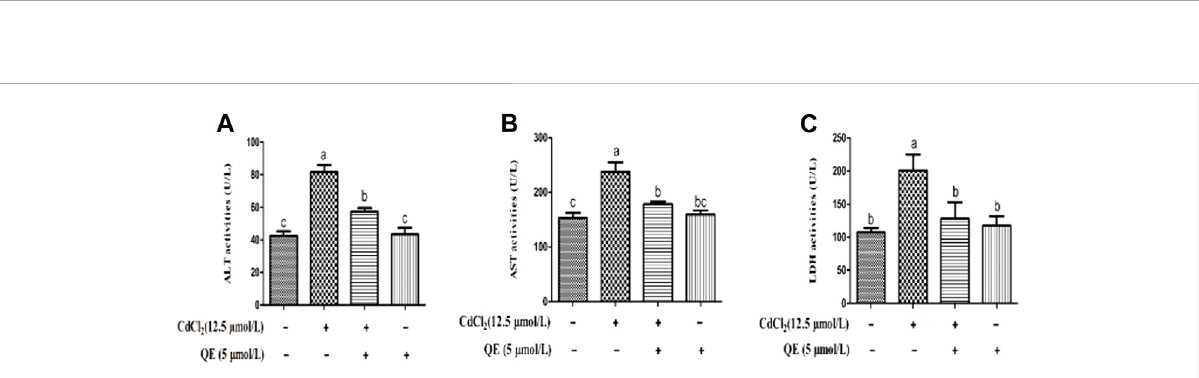
FIGURE 2 Effects of QE on Cd-induced changes in the levels of AST, ALT, and LDH in BRL-3A cells. The activities of ALT (A) , AST (B) , and LDH (C) in the medium supernatant were measured. Data are expressed as the mean ± SEM, and data with different letters (a, b, and c) represent signi fi cant differences ( p < 0.05) among different